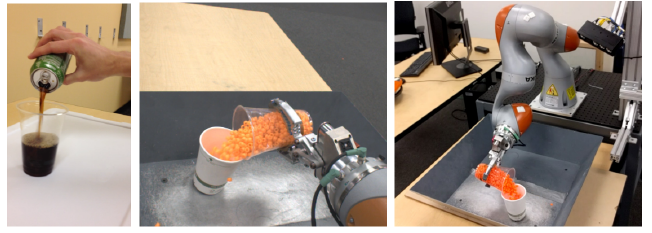
Figure 10. Pouring task with a real robot [99].